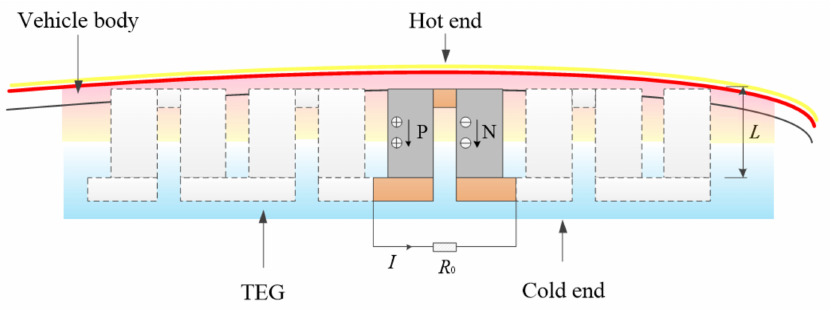
Figure 1. Schematic diagram of aerodynamic heat energy recovery system for